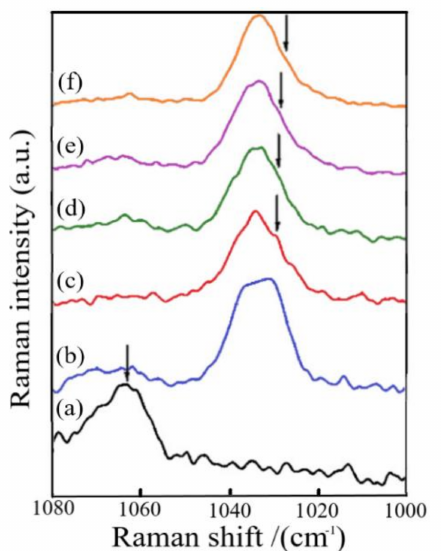
Figure 8. Raman spectra of ( a ) PEO pure film, (b) PEO25 · Mg(Tf) 2 complex, and PEO25 · Mg(Tf) 2 + x wt % EMITf system for ( c ) x = 5, ( d ) x = 10, ( e ) x = 20, and ( f ) x = 30 for spectral region of 1000–1080 cm − 1 . Reproduced with permission from Electrochim. Acta, 56, Kumar et al. Ionic liquid mediated magnesium ion conduction in poly(ethylene oxide) based polymer electrolyte, 3864–3873, 2011